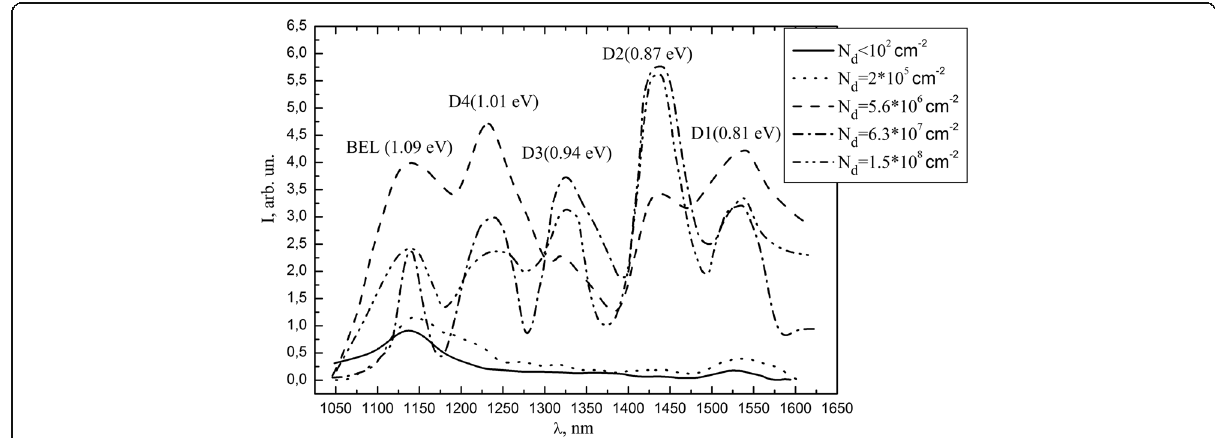
Fig. 1 EL spectrum of samples subjected to plastic deformation with different concentration of dislocations